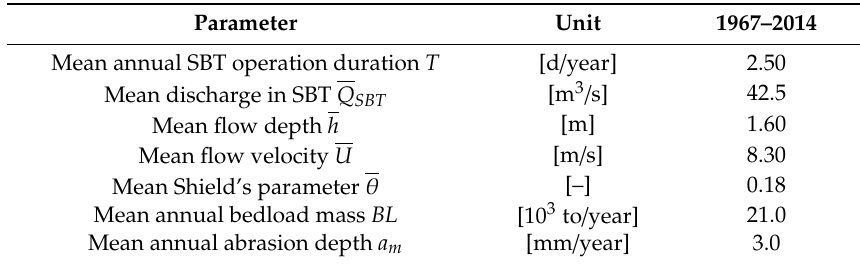
Table 3. SBT operation conditions and abrasion depths in the Val d’Ambra SBT between 1967 and 2014 [48].